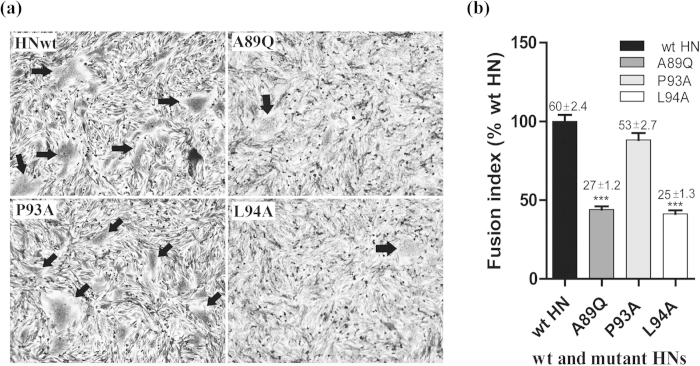
Syncytium formation in BHK-21F monolayers coexpressing HN and F proteins.(a) The extent of syncytium formation is shown for representative BHK-21F monolayers expressing pCAGGS (pCG) vector, wtHN, or HN bearing the A89Q, P93A, or L94A substitution. Cells were fixed with 4% paraformaldehyde and stained with Giemsa. Syncytia are indicated by black arrows. (b) The fusion index of wt HN and HN mutants was calculated as the mean number of nuclei per syncytium. All values are expressed relative to the HN wt value of 100%. The mean and standard error of 20 fusion events for each HN are shown above each column (***P < 0.001).